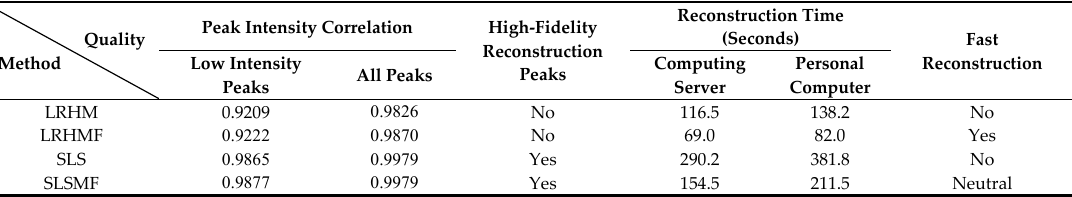
Table 5. Performance comparison of various methods.